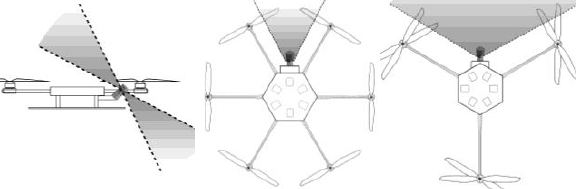
Figure 18 (left) laser head placed at 45 degrees tilting forward Figure 19 (mid&right) Comparison between two hexa-drones in terms